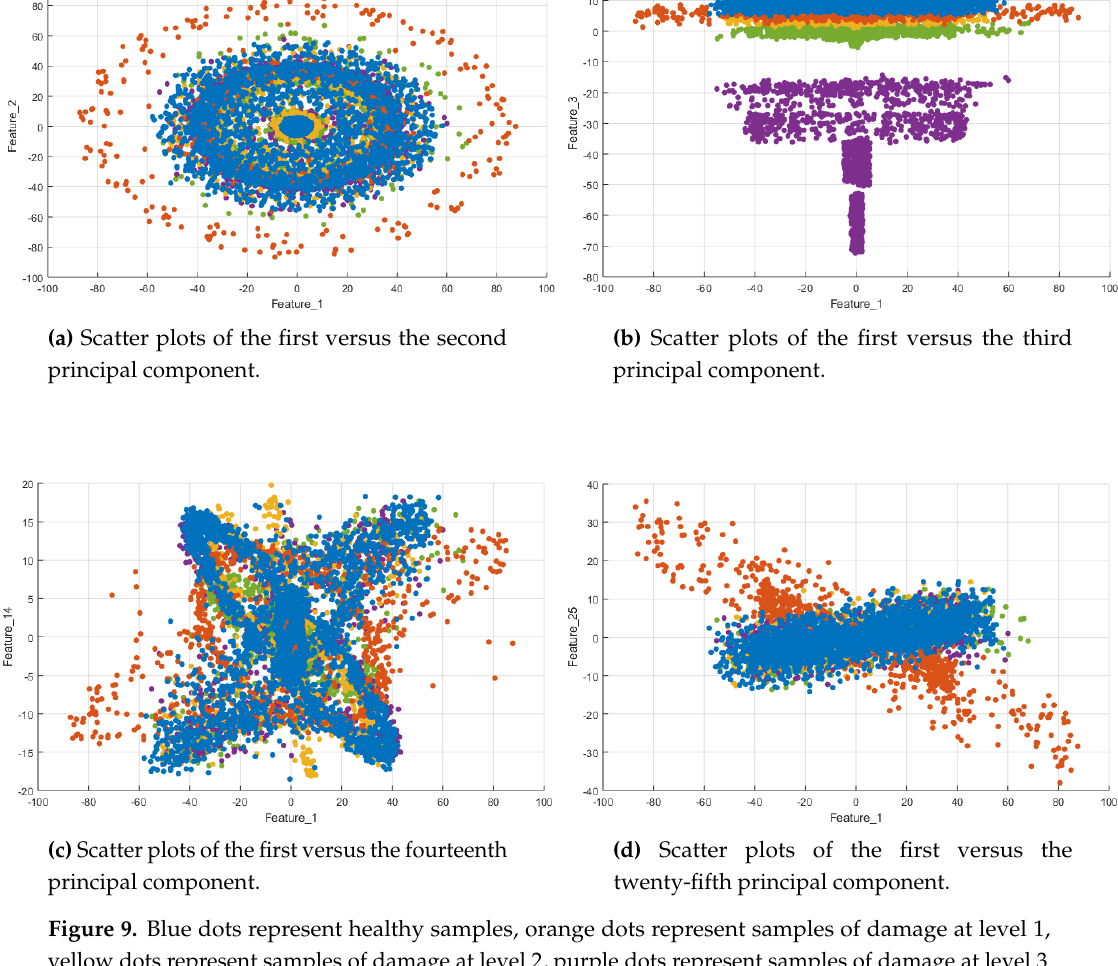
Figure 9. Blue dots represent healthy samples, orange dots represent samples of damage at level 1, yellow dots represent samples of damage at level 2, purple dots represent samples of damage at level 3 and green dots represent samples of damage at level